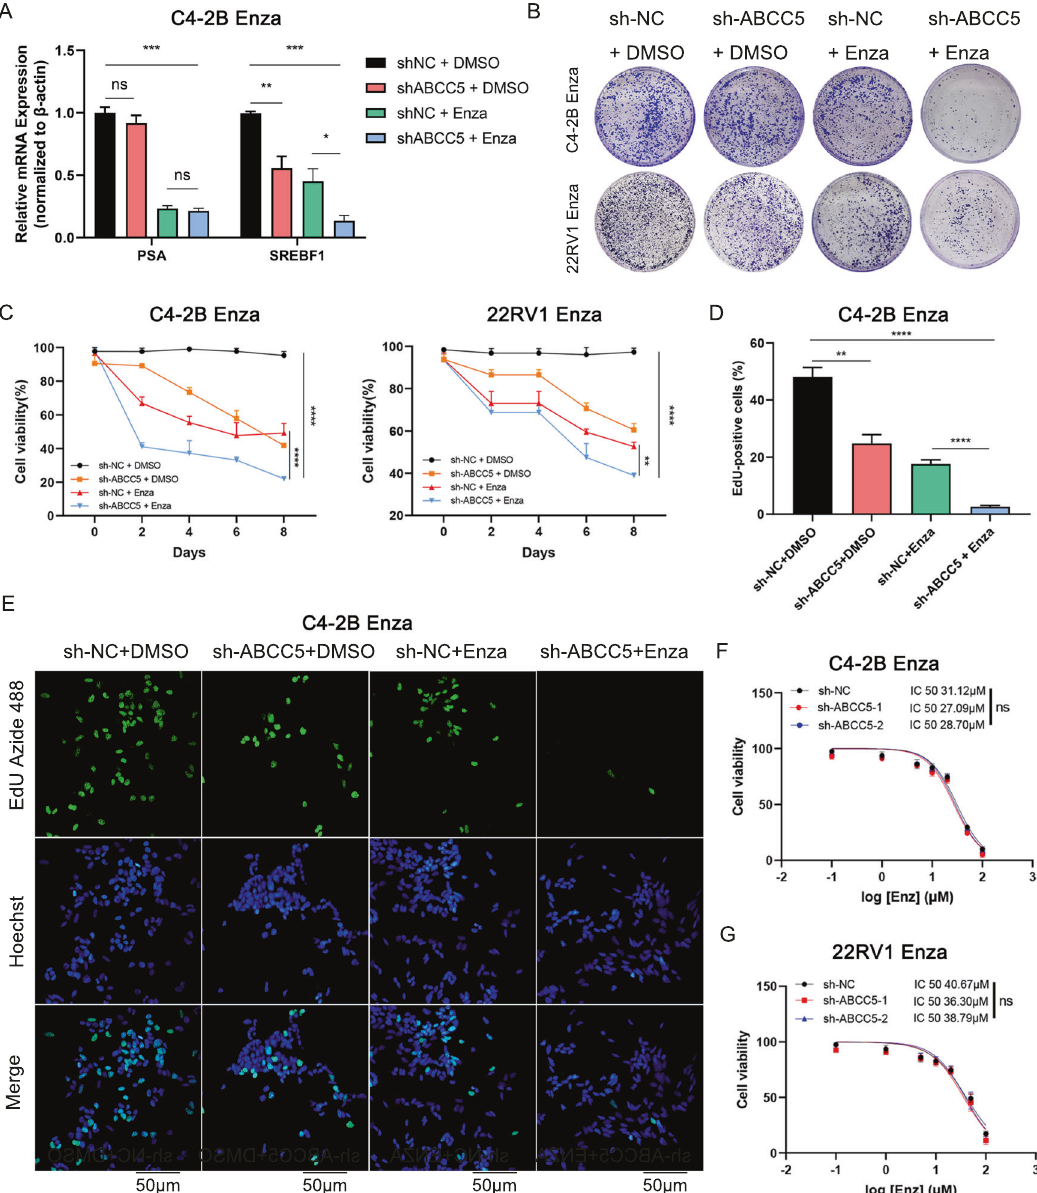
30 μ M enzalutamide for 48 h. * P < 0.05, ** P < 0.01, *** P < 0.001, n.s., not signi fi cant. B Colony formation assays were used in ABCC5-knockdown C4-2B Enza and 22RV1 Enza cells. C C4-2B Enza and 22RV1 Enza cells were cultured in 96-well plates for selected days followed with enzalutamide (30 µM) and harvested for CCK-8 assays. D The EdU positive cells were quali fi ed to analyze relative percentage in C4-2B Enza cells in three experiments. E Proliferation ability was detected by EdU assay to compare ABCC5 depletion and NC group with or without